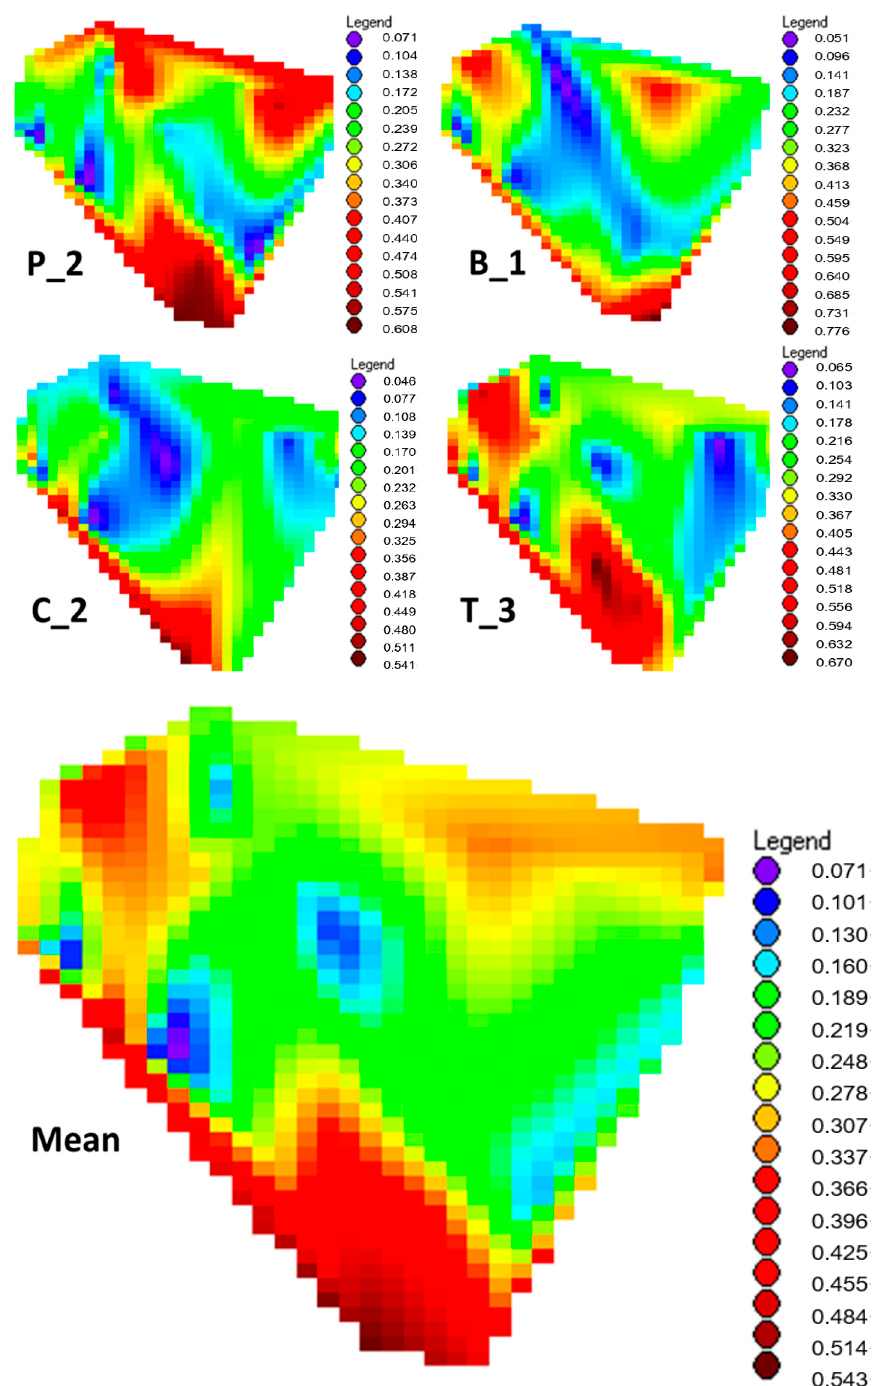
Figure 4. The interpolated contour plots of the GENECLASS assignment probabilities of the four ancient sea pine tree samples (P_2, B_1, C_2, C_3) to each of the 27 autochthonous present-day reference populations of Scots spine plotted on a simplified map of Lithuania. The mean assignment probability of these four sea pine trees is given in the lowermost contour map.